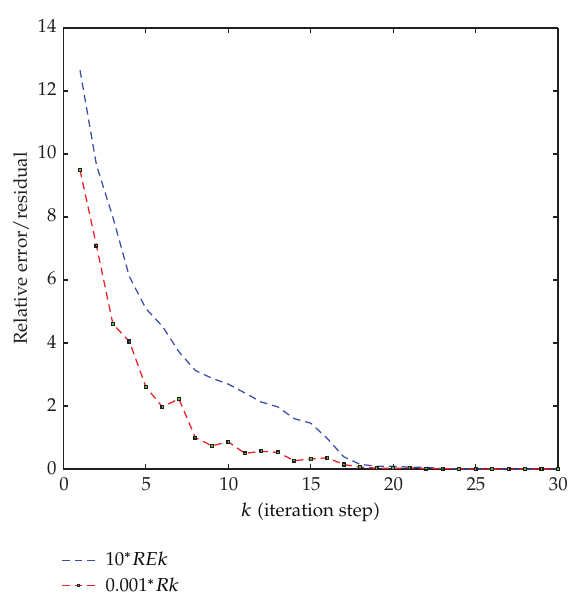
Figure 2: The relative error of the solutions and the residual for Example 4.1 with X 1 (cid:4) 0 , Y 1 (cid:4)